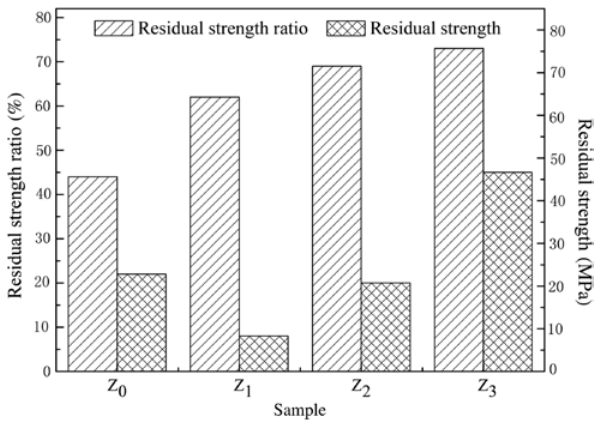
Figure 8 Residual strength ratio and residual strength of samples ( Δ T = 1100 ° C).